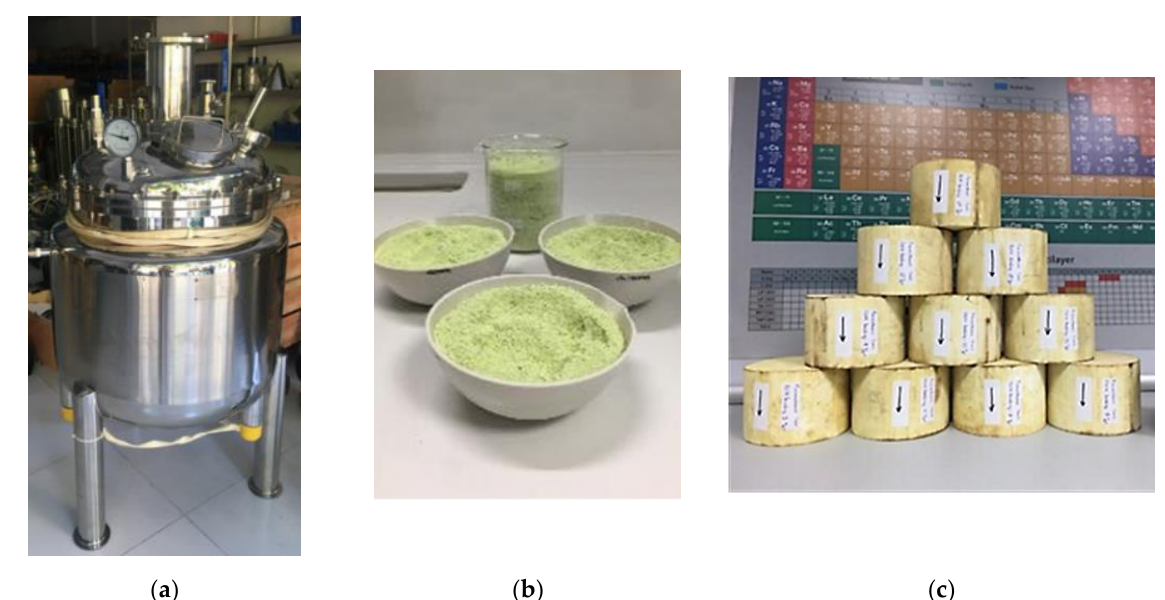
Figure 2. Large scale synthesis of Prometheus monolithic catalysts: ( a ) 150 L jacketed SS316 tank reactor; ( b ) Prometheus catalytic powder; ( c ) Prometheus monolithic catalysts.